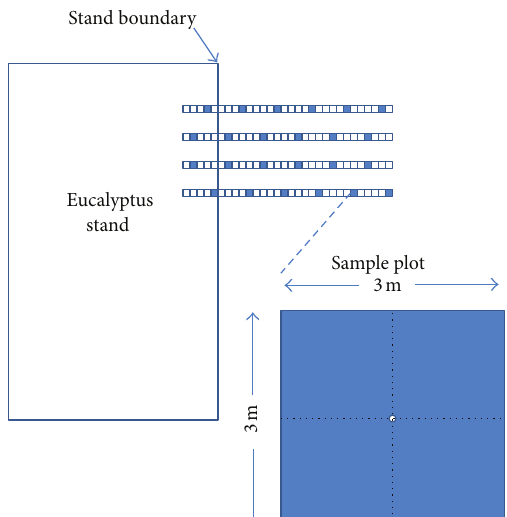
F 1: Schematic diagram of sampling design. Transects were 90m in length, containing 30 cells 3 3m. e �rst cell was randomly selected from the �ve cells inside the stand boundary, and then cells were systematically sampled every 15m throughout × the length of the transect. For example, in the 4 transects shown in the �gure, only blue cells would be sampled for seedlings and environmental variables. Transects were oriented perpendicular to the boundary edge and evenly spaced around the entire Eucalyptus